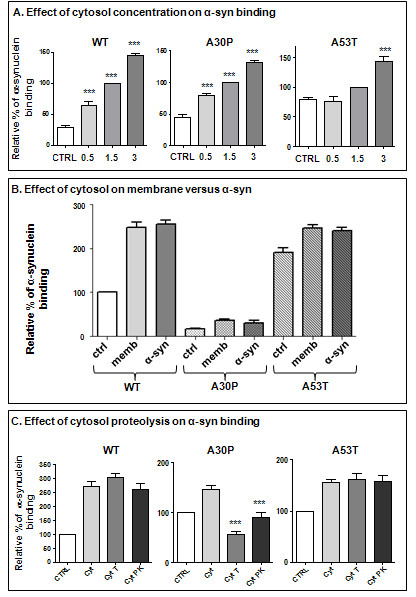
Effect of cytosol on binding α-syn. (A) Recombinant α-syn (Wt, A30P and A53T) were incubated in presence of different concentrations of KO cytosol (0.5, 1.5, and 3 mg/ml), for 10 min at 37°C. Compared to the control condition (without cytosol), all cytosol concentrations had a significant effect on Wt and A30P α-syn binding, but only the highest concentration of cytosol had a significant effect on A53T α-syn binding (One way ANOVA test, p < 0.0001, Bonferroni's multiple comparison post-test). (B) KO synaptic membranes and α-syn were pre-incubated for 15 minutes at room temperature with KO cytosol. Membranes were then centrifuged at 14000 × g and washed with KOAc buffer to remove unbound factors. Binding of purified α-syn to KO membranes in the absence of cytosol (ctrl) was compared to its binding to cytosol-treated membranes without added cytosol (memb), and to cytosol-treated α-syn incubated with KO membranes (α-syn). No significant difference was observed between the two pre-incubated condition (Student T-test, p > 0.05). (C) KO cytosol was pre-incubated with trypsin or proteinase K for 15 min at 37°C. Enzymes were then respectively inactivated with trypsin inhibitor and PMSF for 10 min at room temperature. Compared to the cytosol condition (cyt) which, as a control, was incubated with the enzyme pre-inactivated by the inhibitor, only A30P α-syn binding was significantly affected by the cytosolic protein digestion (Student T-test, p < 0.0001), whereas no significant differences were observed for Wt and A53T proteins (Student T-test, p > 0.05).